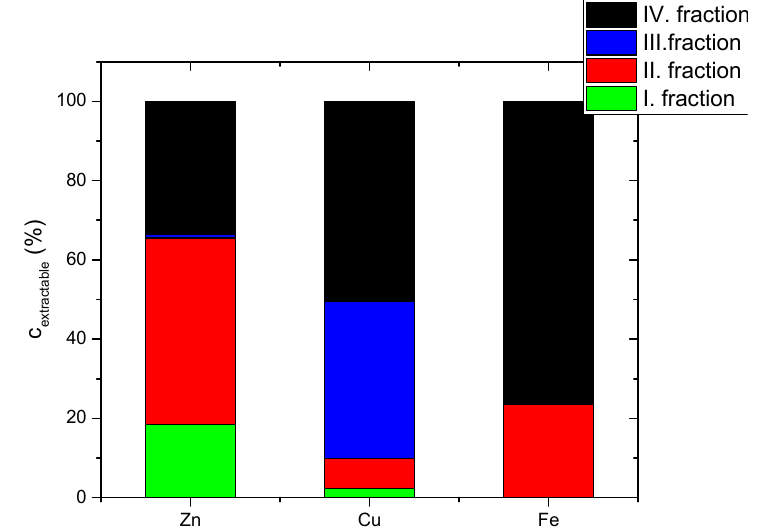
Figure 3. BCR sequential extraction protocols of Zn, Cu and Fe from PM. I. fraction represents water-extractable metal ions, exchangeable ions and ions bound in carbonates; II. fraction represents metal ions bound in Fe and Mn oxides; III. fraction represents metal ions incorporated in organic matter and sulfides; IV. fraction represents the residual fraction of metals.